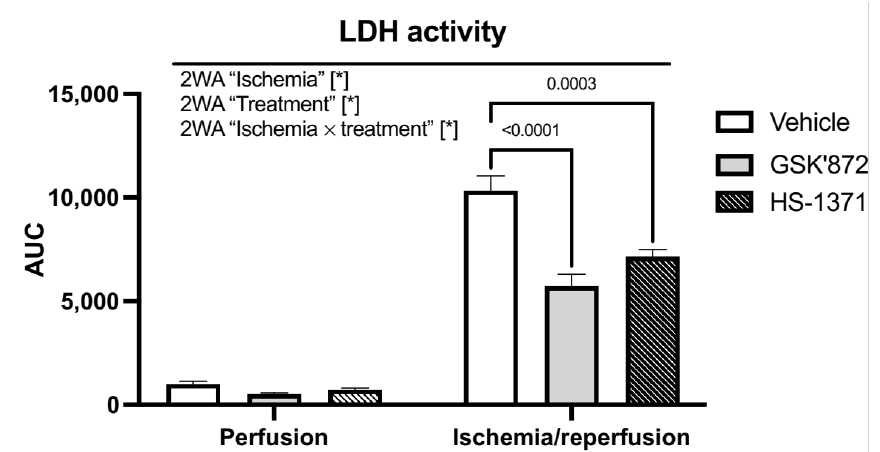
Figure 1. Analysis of the effect of RIP3 inhibition on LDH activity. Data are presented as mean ± SEM; * p < 0.05. 2WA—two-way ANOVA; “Ischemia”—presence of ischemia/reperfusion; “Treatment”— presence of GSK’872 or HS-1371; “Ischemia × treatment”—interaction of the two